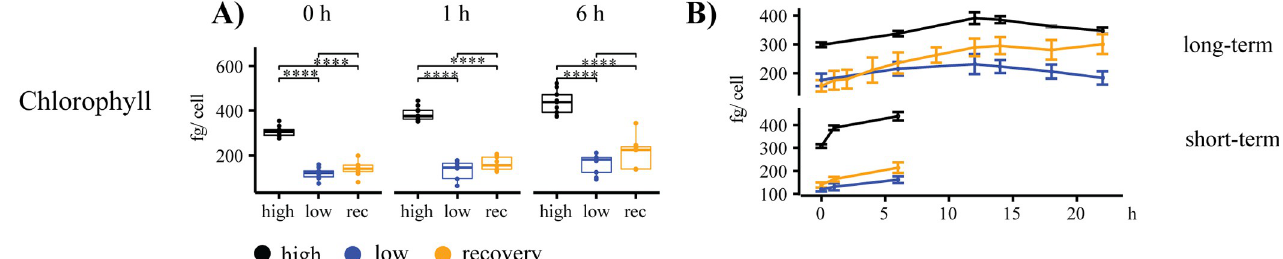
Fig 2. Changes in cellular chlorophyll content. Box plots (A) and short- and long-term time-courses (B) of chlorophyll. High-iron, low-iron, and iron- recovery samples are shown in black, blue, and orange, respectively. A two-tailed Student’s t-test was used for the statistical analysis of box plots (A). Box plots represent duplicate measurements of three experiments (n = 6) for each time point (0 h, 1 h, 6 h). Line graphs (B) show trends throughout the long-term and short-term experiments. Error bars represent standard errors (S.E.). Statistically significant P values are indicated as � < 0.05, �� , 0.01, ��� < 0.001, ���� < 0.0001. A line without stars indicates a test that is not statistically